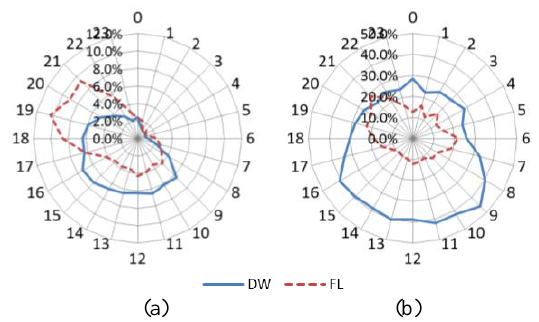
Figure 8. Daily variations: (a) proportion to each type of fire; (b) proportion to all fire